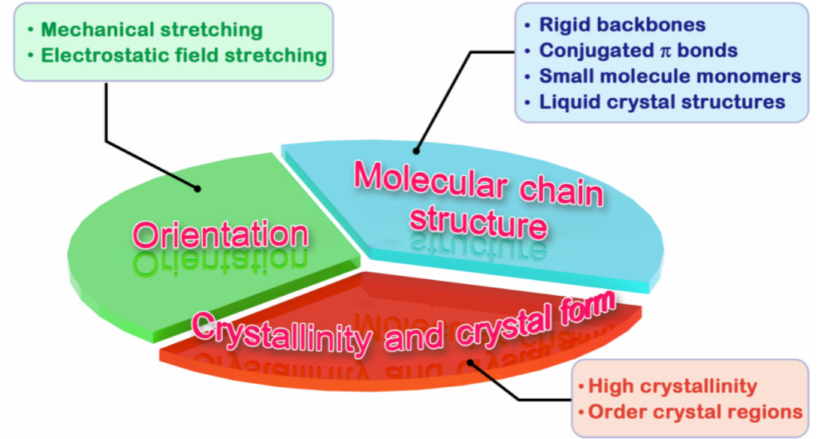
Figure 2. Thermal conductivity of intrinsic thermally conductive polymers depends on various factors that need to be